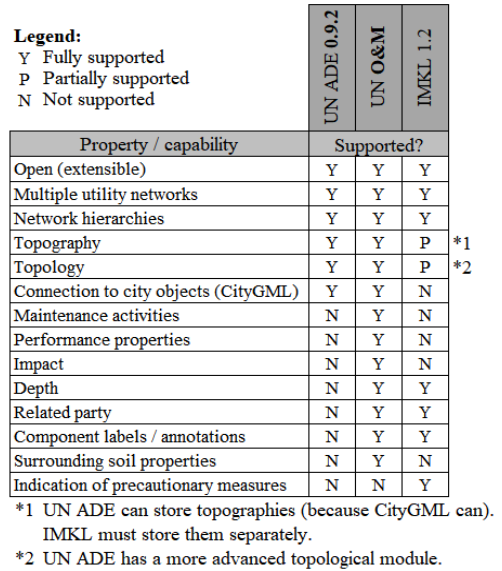
Table 1. Comparison of Utility Network ADE 0.9.2, Utility Network O&M and IMKL2015